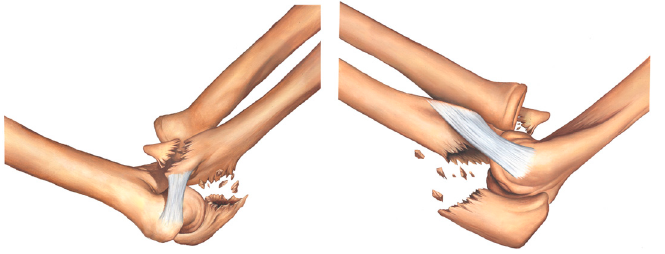
Figure 3. Type IB fracture—transolecranon fracture of the proximal ulna with associated fracture of the coronoid process and no involvement of the sublime tubercle and supinator crest.